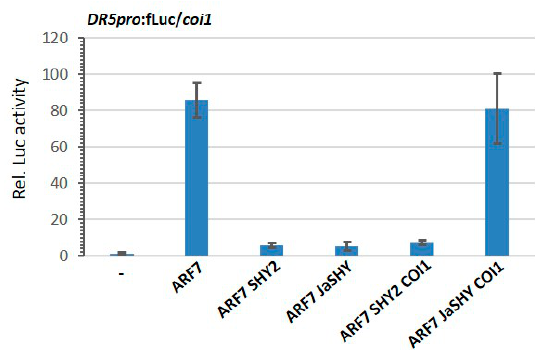
Figure 4. The ARF7 transcriptional activity was released upon JaSHY degradation by COI1. Arabidopsis leaf protoplasts prepared from coi1 mutant plants were co-transfected with promoter-driven reporter plasmid DR5pro :fLuc and effector plasmids encoding ARF7, SHY2, JaSHY, or COI1 under the control of UBQ10 promoter. Firefly luciferase (fLuc) activities were normalized to Renilla luciferase (rLuc) activities. Reporter activities of fLuc without effector vector were set to one. Values represent means (±SE) of four independently transformed batches of protoplasts.